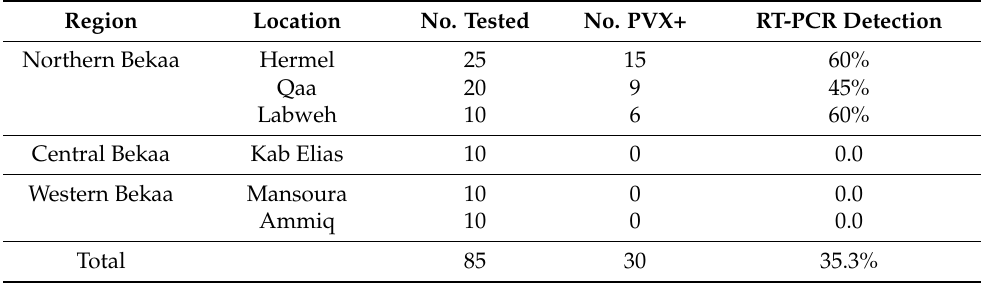
Table 3. Prevalence of PVX infections revealed by RT-PCR test in eggplants plants different regions in Bekaa